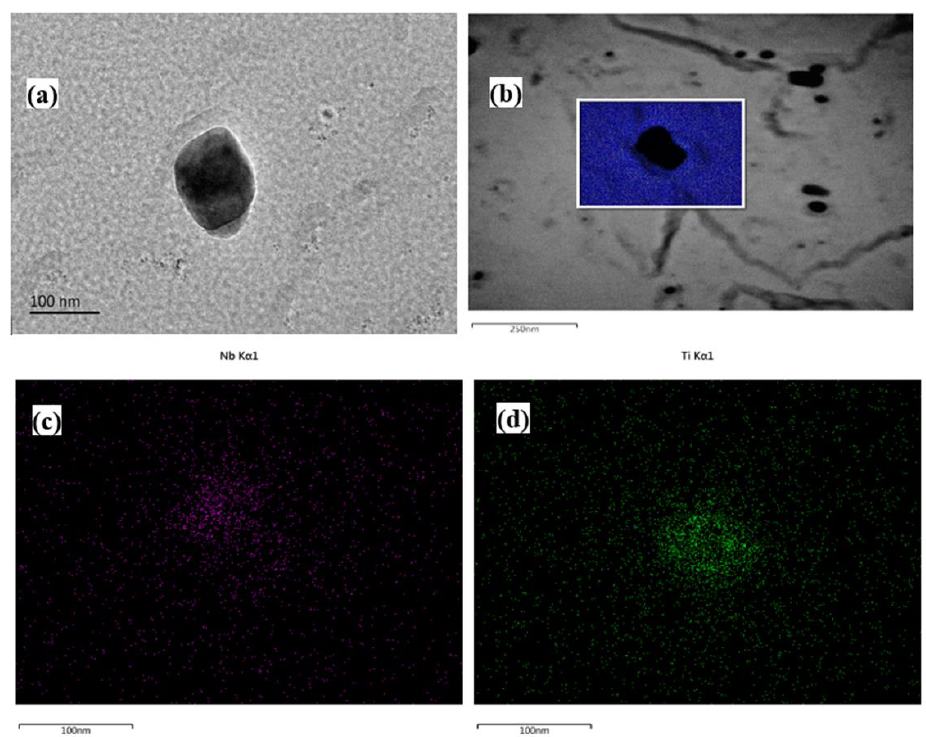
Figure 12. Morphology and surface scan of large size precipitation of experiment steel at peak temperature of 950 ◦ C under the heat input of 10 kJ/cm: ( a ) precipitation particle morphology; ( b – d ) the particle mapping and element distribution.